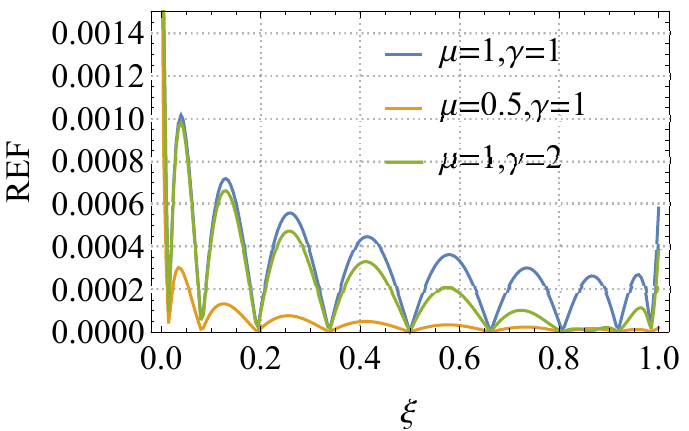
Figure 3. Graph of the solutions of Model 2, with α = 1.5, T = 1, m = 10 and τ = 0.00001, and for different values of µ and γ .